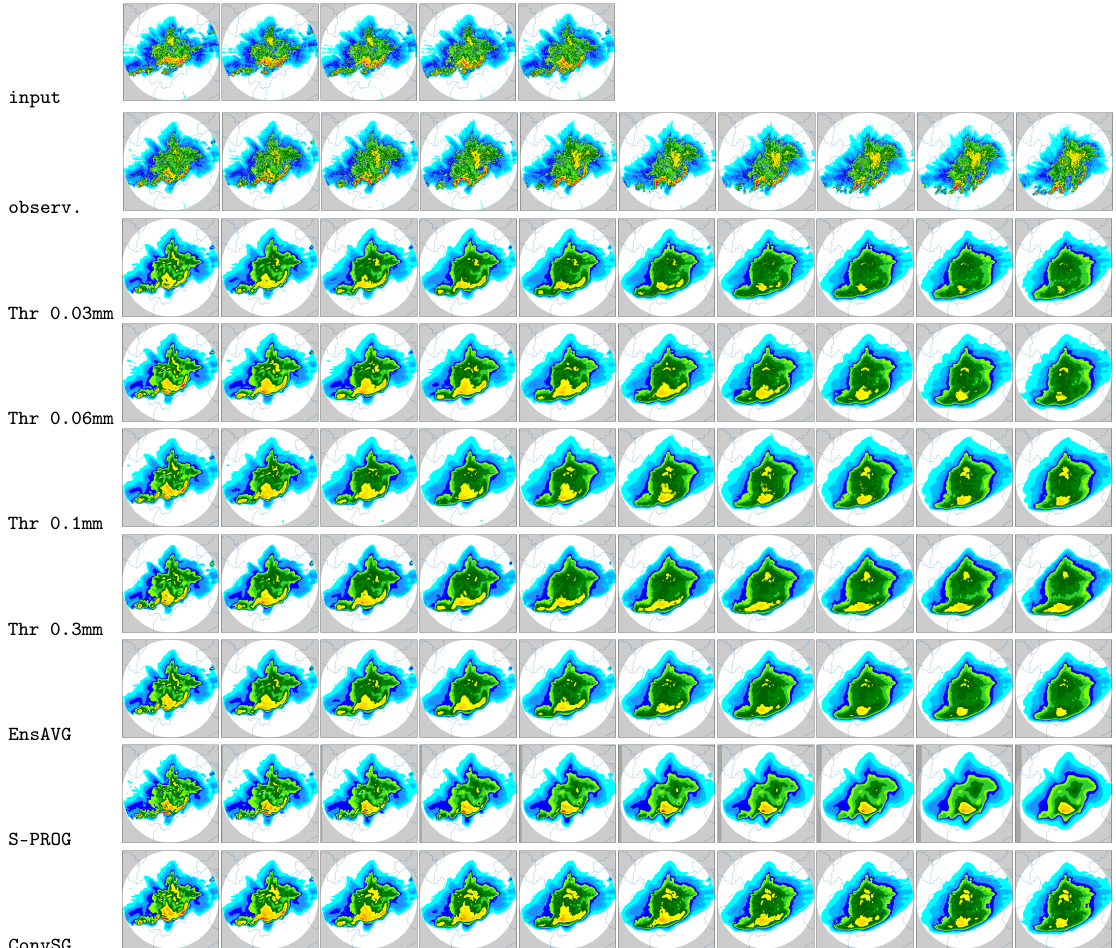
Figure 13. TRE Ensemble members, Ensemble average, S-PROG, and ConvSG (Ens + Oro) prediction on test at 1535 UTC 03 July 2018 (best viewed in color). The first row shows the five input scans (25 min), while the subsequent rows (50 min) show the observation (ground truth), the four models’ output, the ensemble average, the Lagrangian extrapolation model, and the stacked generalization